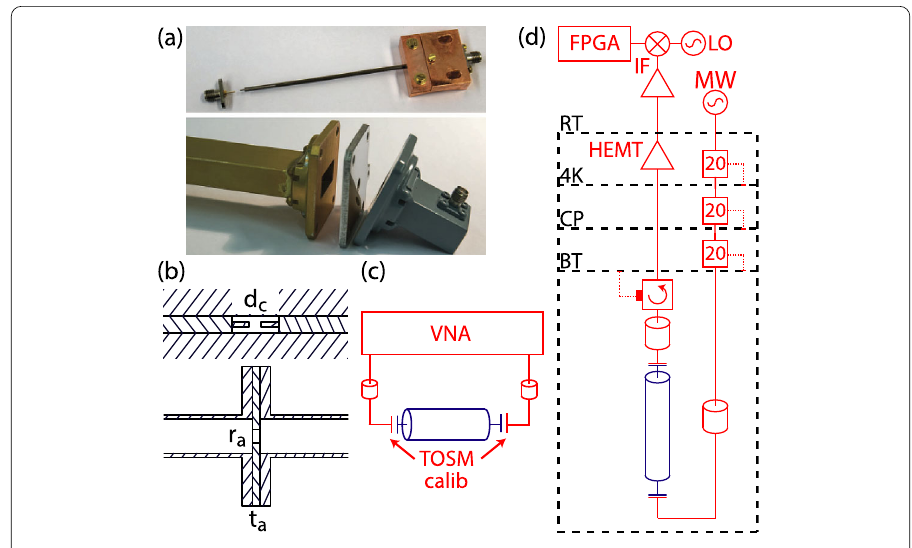
Figure 1 Overview of the experimental setup. Photographs (a) and schematics (b) of a capacitively coupled coaxial cable and an aperture coupled rectangular waveguide. (c) Schematic of the room temperature setup using a vector network analyzer (VNA). A through-open-short-match (TOSM) calibration is used to account for loss and phase offsets in the interconnecting cables. (d) Schematic of the FPGA-based microwave setup [35] used for measurements at cryogenic